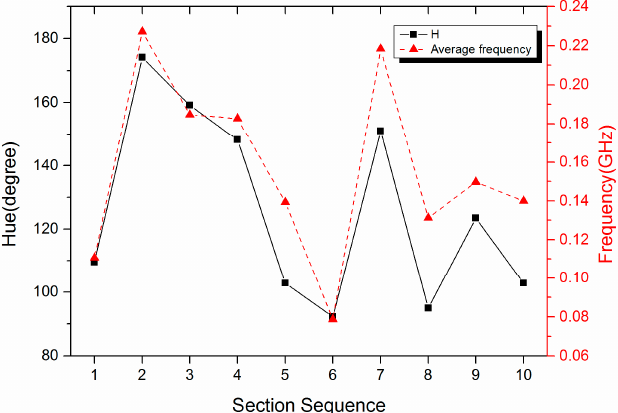
Figure 4. Comparison of waveforms between parameters H and the average frequency of the UHF-B frequency spectrum.